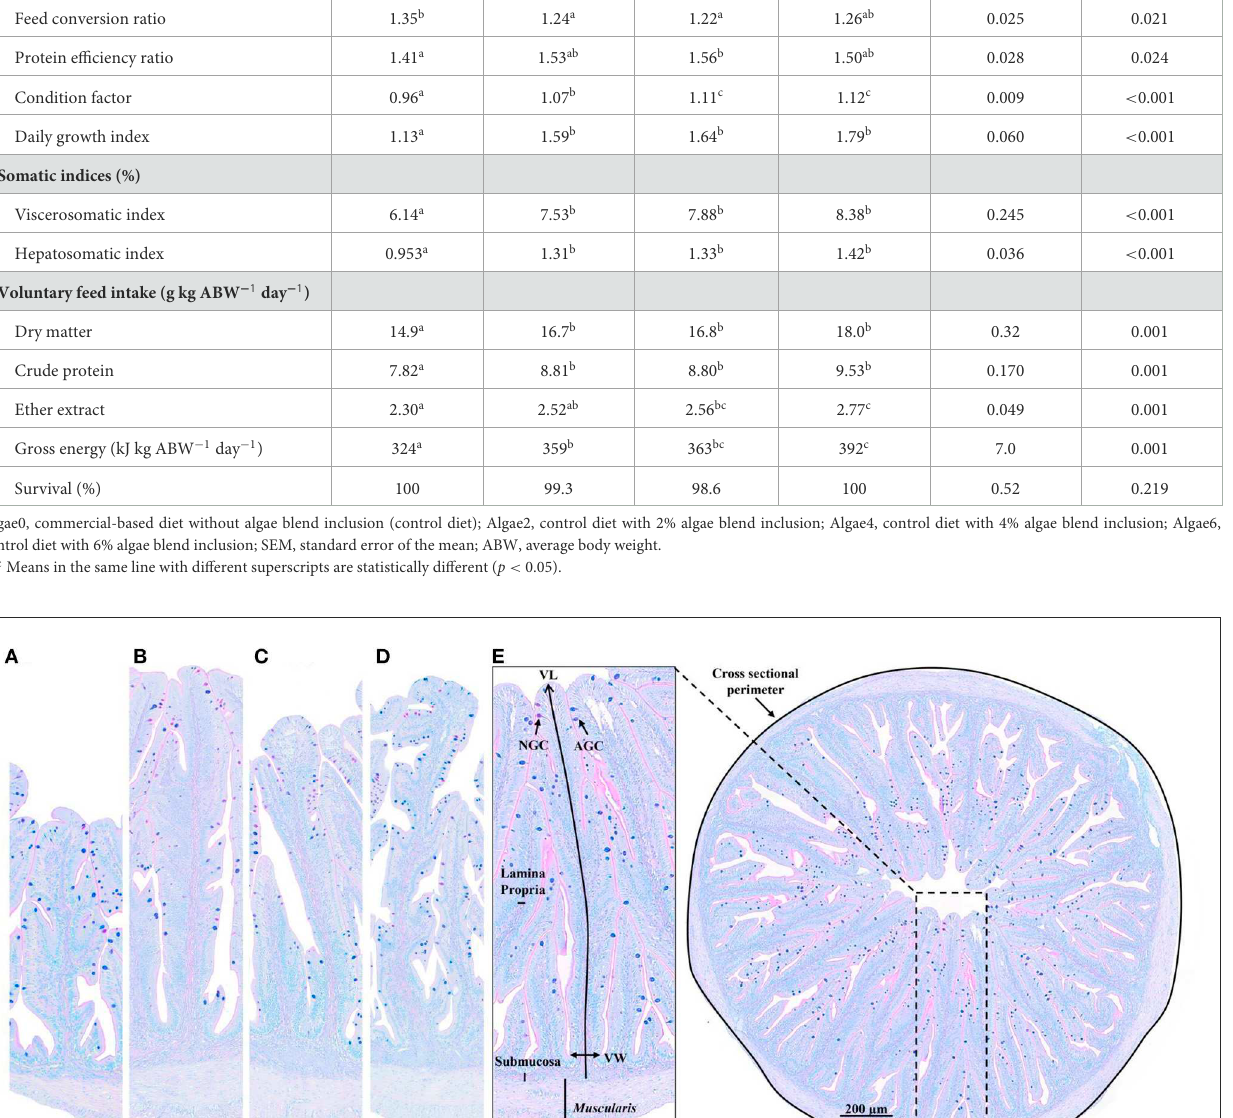
unchanged, reflecting the effect on C16:0 ( p > 0.05). Total MUFA, C16:1 n -7, and C18:1 n -9 proportions were the highest in fish fed with 6% algae blend and the lowest in those fed control (0%)